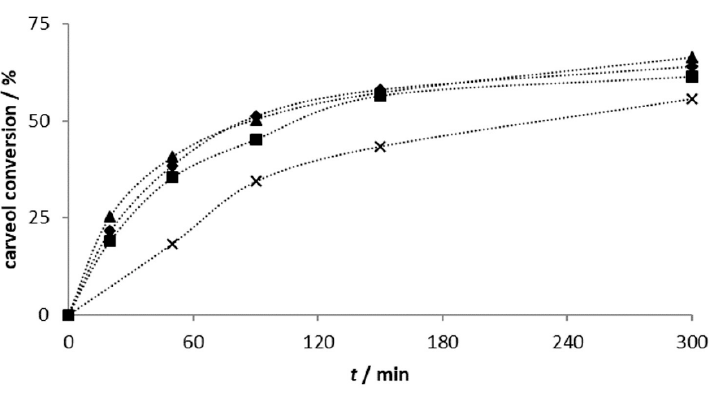
Figure 3. Converted carveol vs. time with molybdenum(VI) (pre)catalyst ♦ complex 1 , ■ complex 1a , ▲ complex 2 , × complex 2a . Conditions: n (Mo): n (substrate): n (THBP aq ) = 1:400:800, T = 353 K.